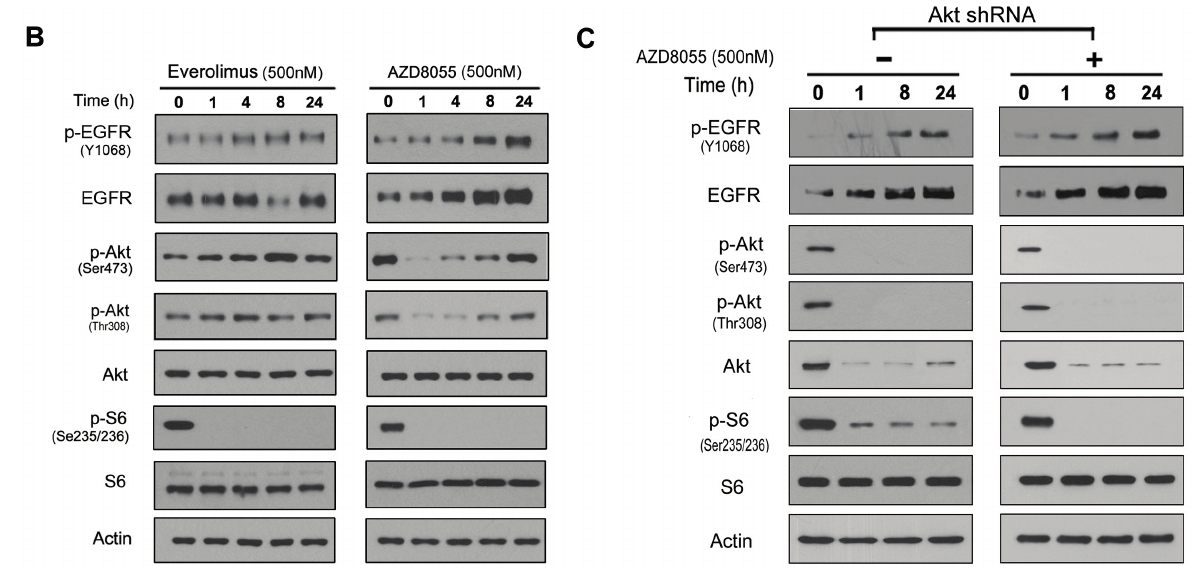
Figure 2. AZD8055 induces EGFR upregulation in an AKT dependent manner. ( A ) PANC-1 cells were untreated or treated with AZD8055 and lysates were applied to phospho-RTK array. The p-EGFR dot blots were indicated by arrow; ( B ) PANC-1 cells were treated with AZD8055 for the indicated hours and EGFR (T/P), AKT (T/P) and ribosomal protein S6 (S6) (T/P) proteins were examined by western-blot; ( C ) PANC-1 cells were transfected with AKT shRNA and treated with AZD8055 for the indicated hours, then above proteins were examined by